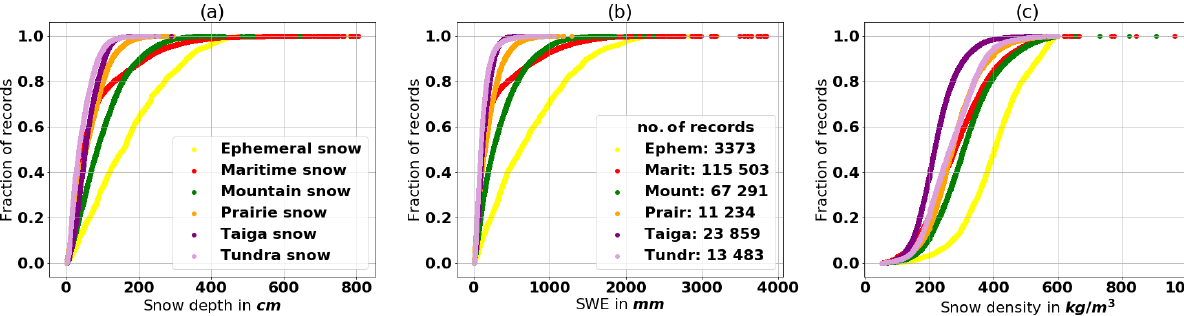
Figure 2. The empirical cumulative distribution function (ECDF) of the variables snow depth, SWE, and density for each snow